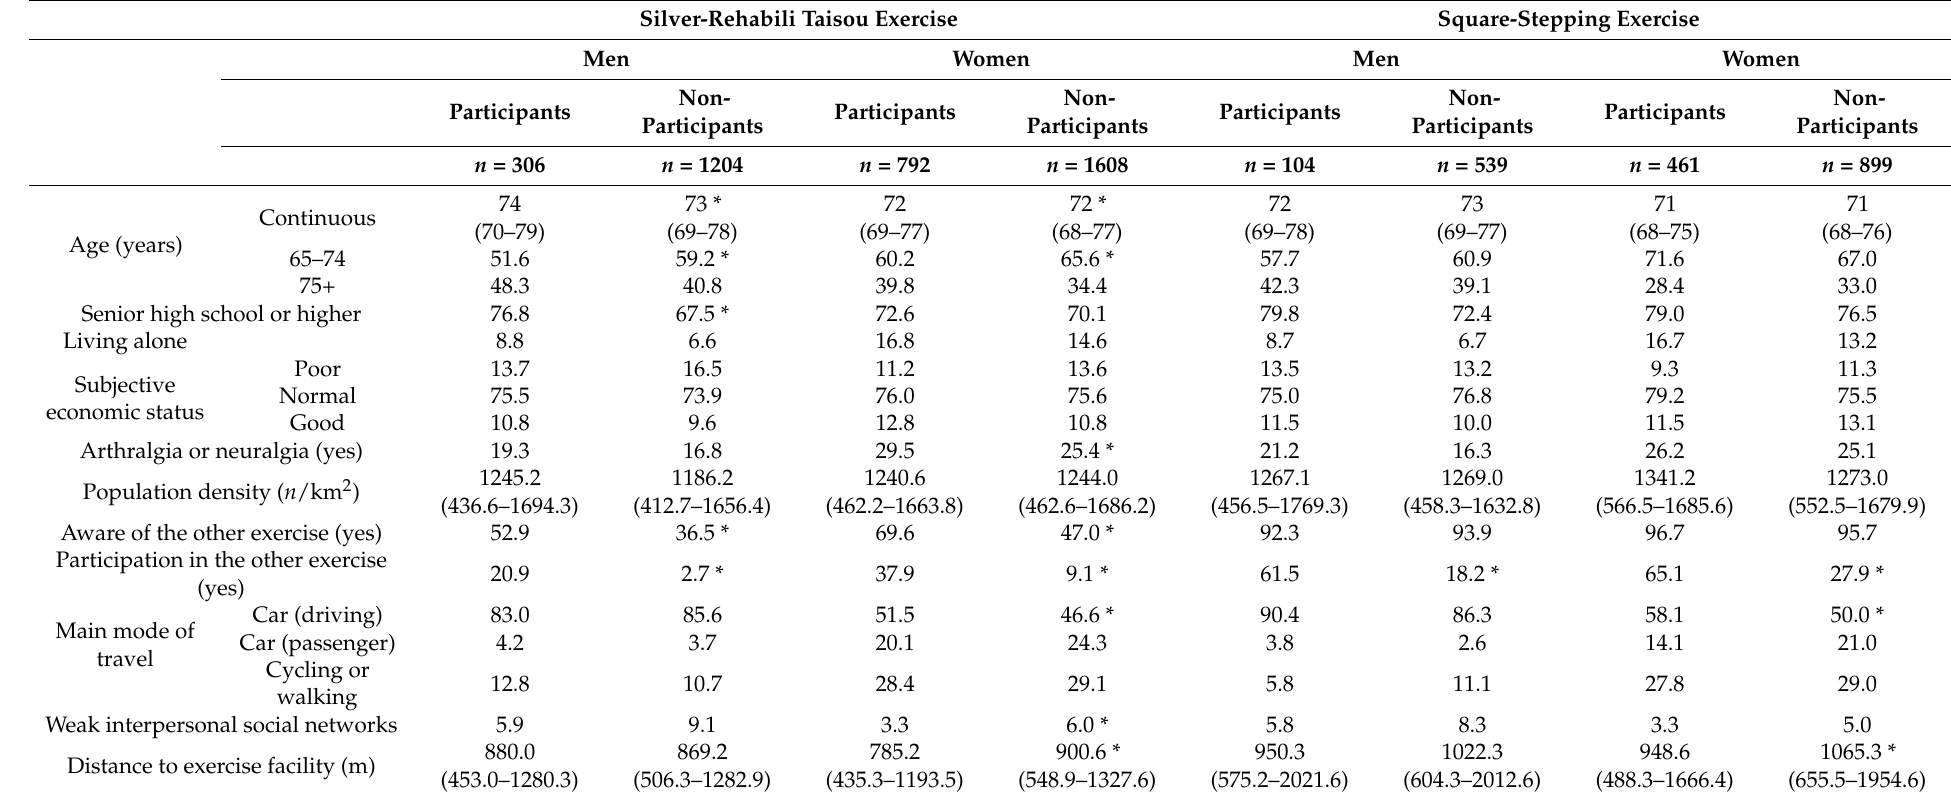
Table 1. Characteristics of the